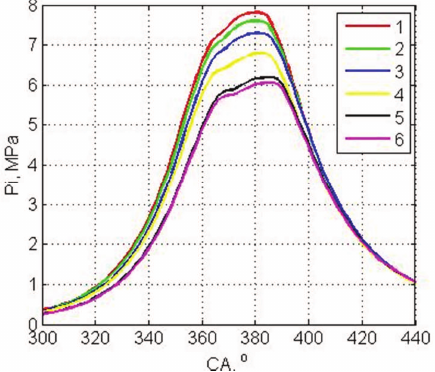
Fig. 5. In-cylinder pressure course at engine rotational speed 1600 rpm at 190 Nm load for different EGR opening level (1 – 0%, 2 – 3%, 3 – 8%, 4 – 15%, 5 – 50%, 6 – 100%) One of the basic parameters describing in-cylinder pressure is its maximum value. The effect of the EGR valve opening on the maximum cylinder pressure is shown in Fig. 6.